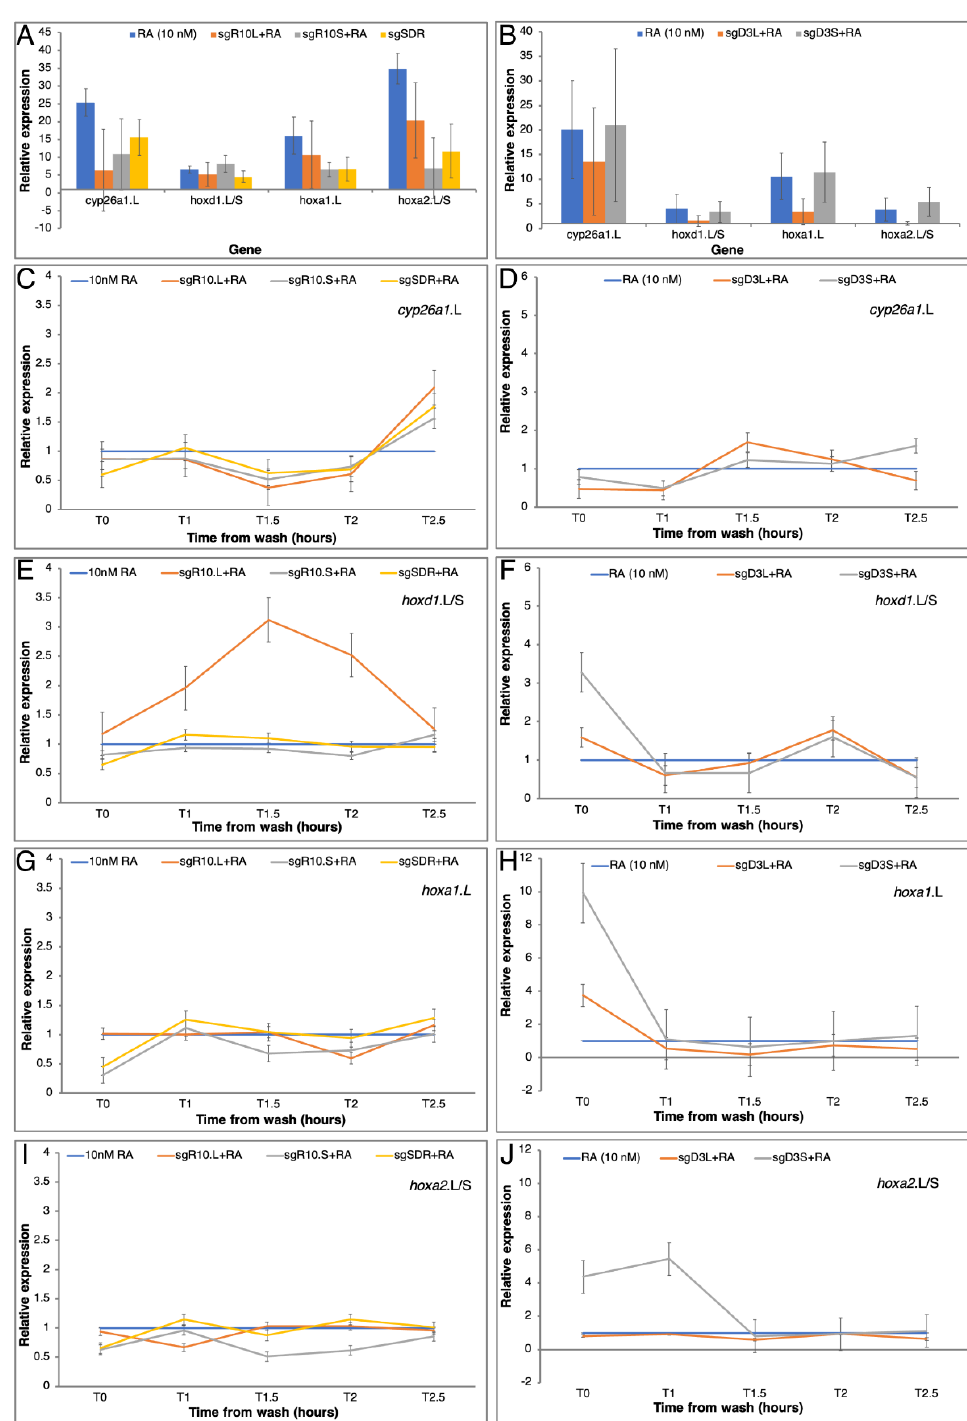
Figure 7. Gene expression changes in RA responsive genes as a result of homoeolog knockdown. RA network component gene specific knockdowns were induced by targeting genes with CRISPR/Cas9. The rdh10 .L, rdh10 .S, and sdr16c5 ( A , C , E , G , I ), and dhrs3 .L and dhrs3. S ( B , D , F , H , J ) genes were targeted with specific sgRNAs. CRISPant embryos were treated with RA (10 nM) and sibling embryos were treated with RA only as controls. ( A , B ) Gene expression change analysis at T0 normalized to control expression. ( C – J ) Kinetic analysis of gene expression changes in CRISPant embryos normalized to RA- induced changes at each time point. Genes analyzed: ( C , D ) cyp26a1 .L, ( E , F ) hoxd1 .L/S, ( G , H ) hoxa1 .L, ( I , J ) hoxa2